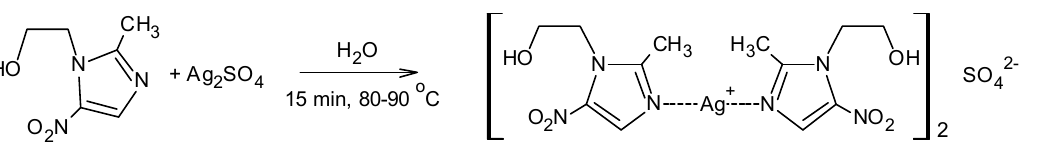
Table 1. Distances of Ag interactions